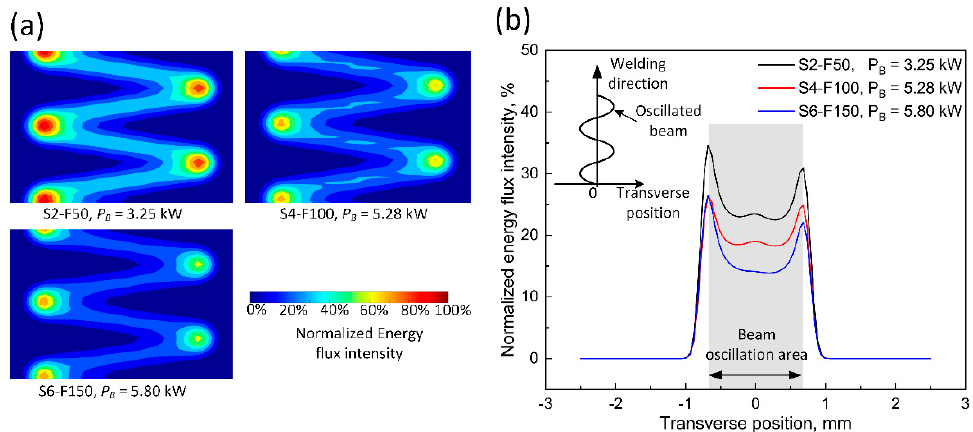
Figure 5. ( a ) Computed energy flux distribution on material surface in each processing window and ( b ) distribution of averaged energy flux intensity along transverse position. Note that energy flux intensity was calculated with Equation (2) normalised by the maximum E(x, y) among three processing windows.